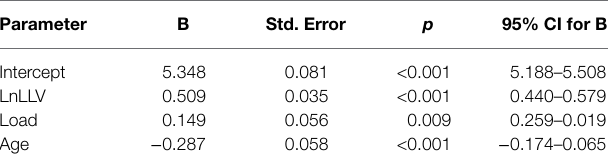
TABLE 5 | Parameter estimates and 95% CIs for the dependent variable, LnMPO, during the repeated sprint protocol when LLV was used as covariate. Parameter B Std. Error p 95% CI for B